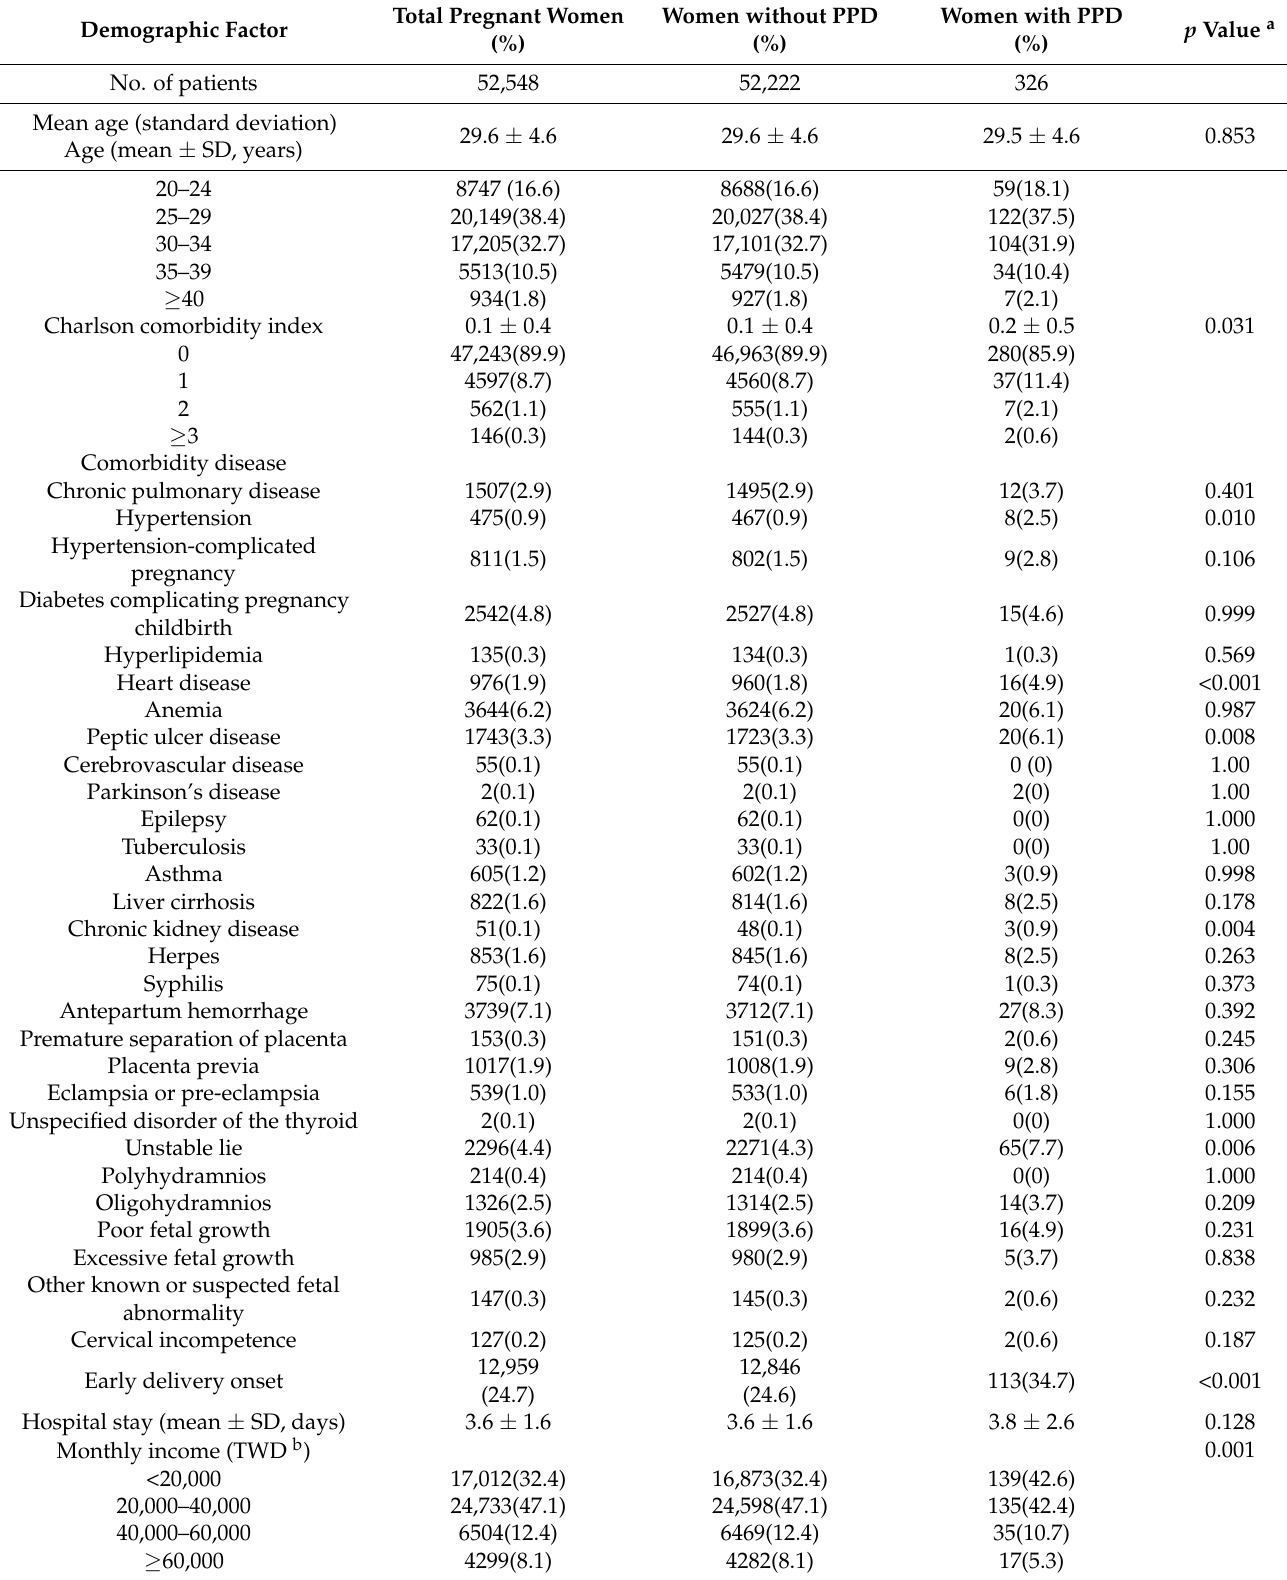
Table 1. Demographic characteristics associated with the subjects in Taiwan, 2000 to